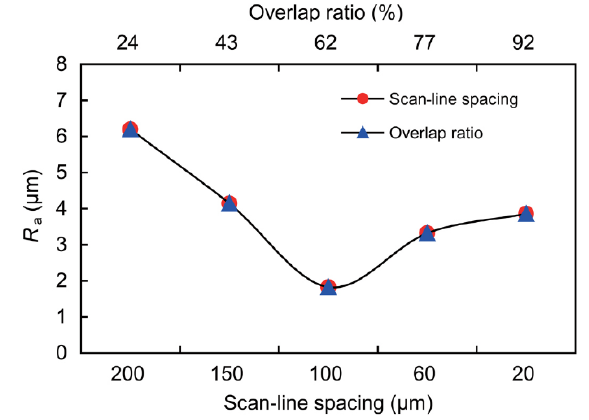
Figure 7. R a as a function of the scan ‐ line spacing and overlap ratio.